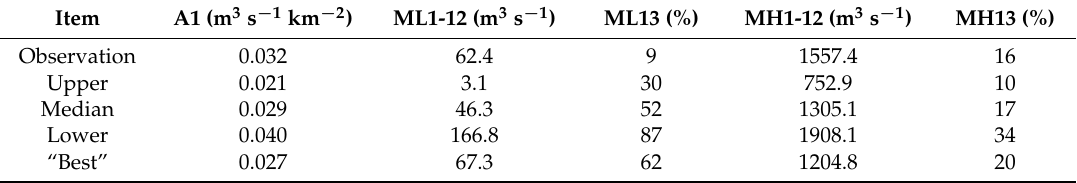
Figure 7. Hydrological signatures derived from simulations based on TRMM 3B42V7. ( a ) Mean annual runoff (A1); ( b ) mean minimum monthly flows (ML1-12); ( c ) mean maximum monthly flows (MH1-12); ( d ) variability across minimum monthly flows (ML13); ( e ) variability across maximum monthly flows (MH13). Table 3. Hydrological signatures derived from observation and behavior simulations.